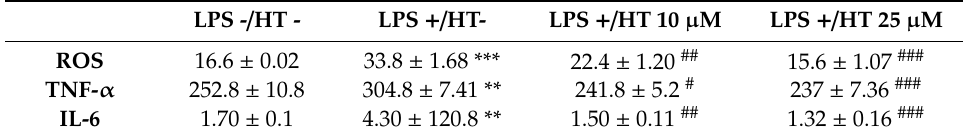
E ff ects of HT on oxidative stress and inflammation in BEND cells stimulated with lipopolysaccharides